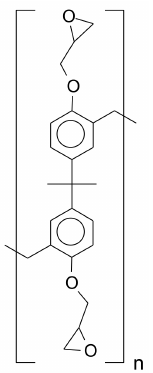
Figure 2. Polymer structure for most of the negative tones of